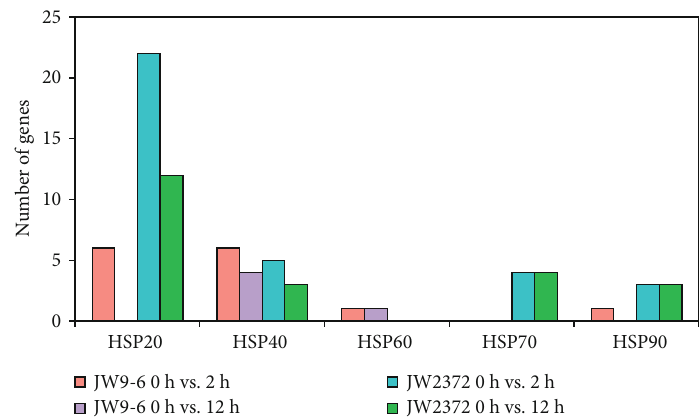
Figure 4: Distribution of di ff erentially expressed heat shock proteins.